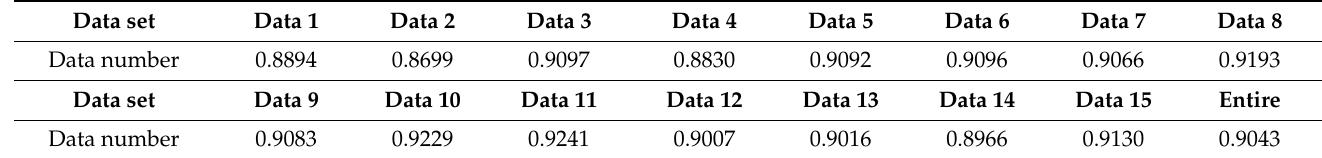
Table 7. Layout accuracy on 15 trail sets in the actual